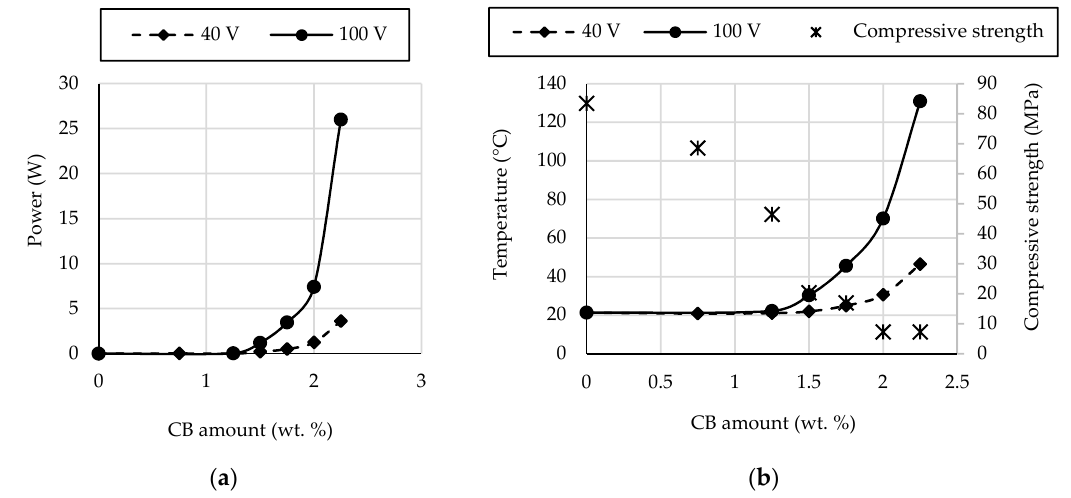
Figure 15. Dependence of ( a ) the power on CB amount (40 V, 100 V); ( b ) maximal achieved temperature and the compressive strength on CB amount (40 V, 100 V).